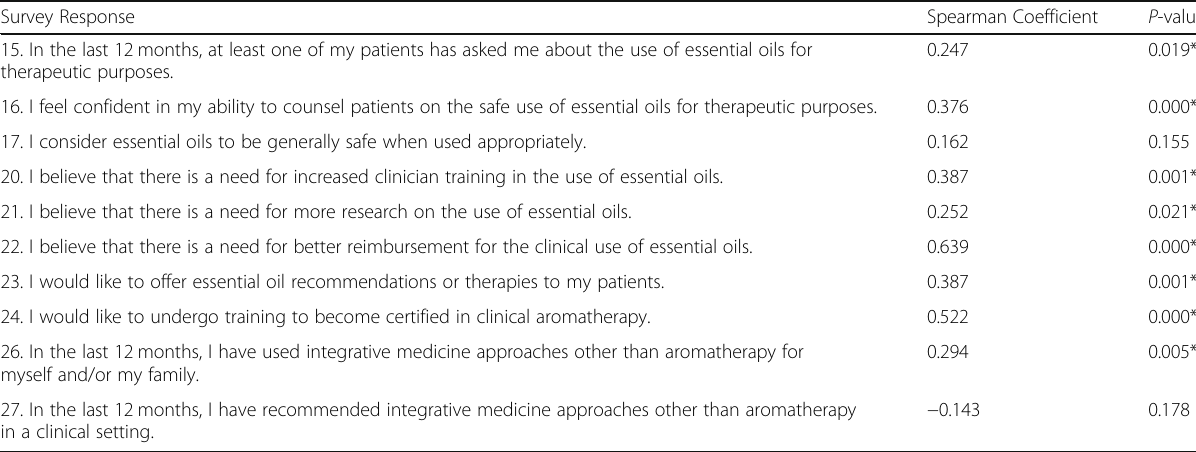
Table 3 Correlation between responses to survey questions and the use of essential oils for self or family in the previous 12 months Survey